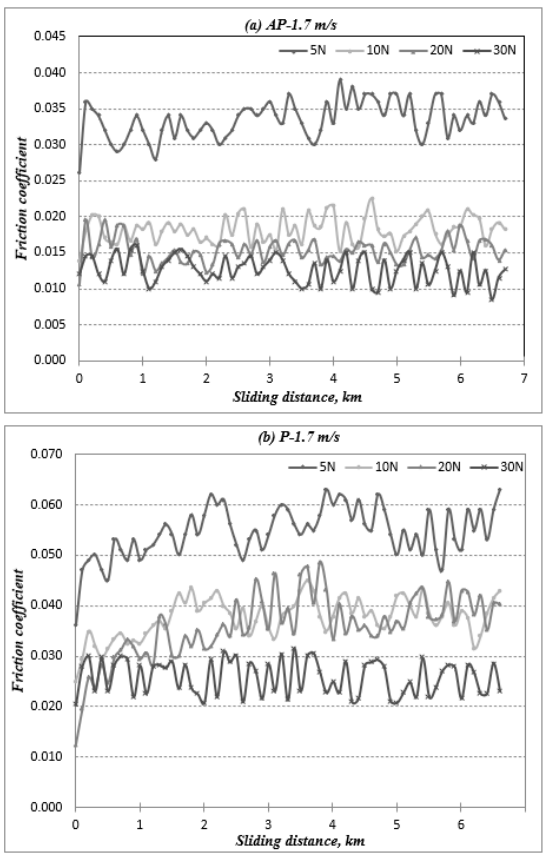
Figure A1. Friction coefficient vs. sliding distance for different fibre orientations (AP and P) subjected to different applied normal loads at 1.7 m/s of sliding velocity.